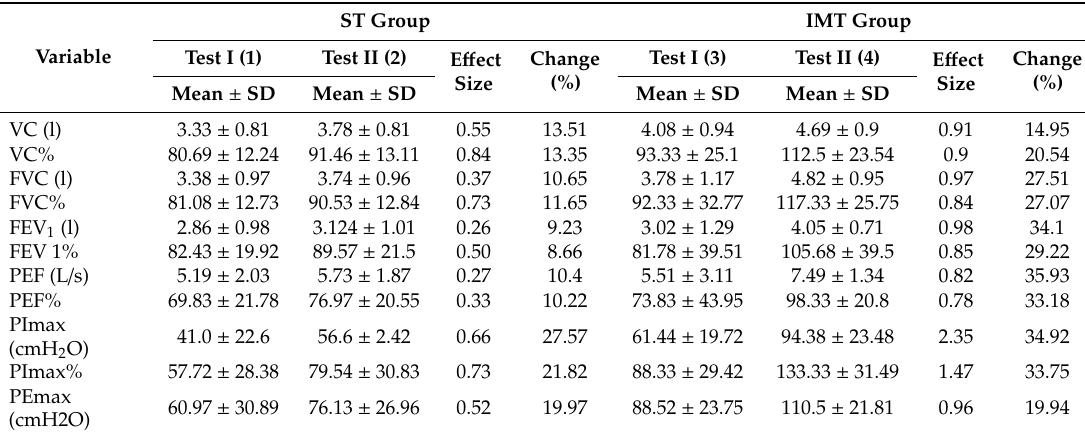
Table 4. Mean values, standard deviations, and the increase in ventilator parameters and PImax, PEmax in the examined